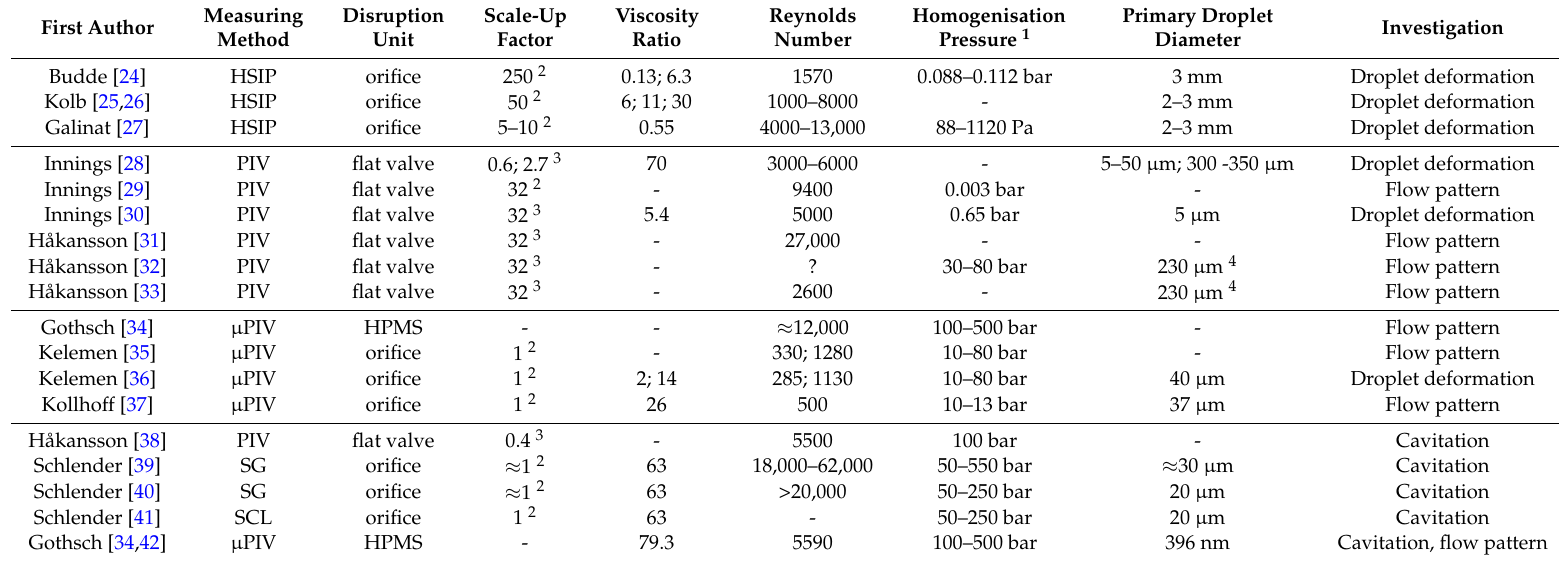
Table 1. Overview of the reviewed studies that eithther investigated velocity fields, droplet break-up or cavitation during the high-pressure homogenisation processes with optical measurement